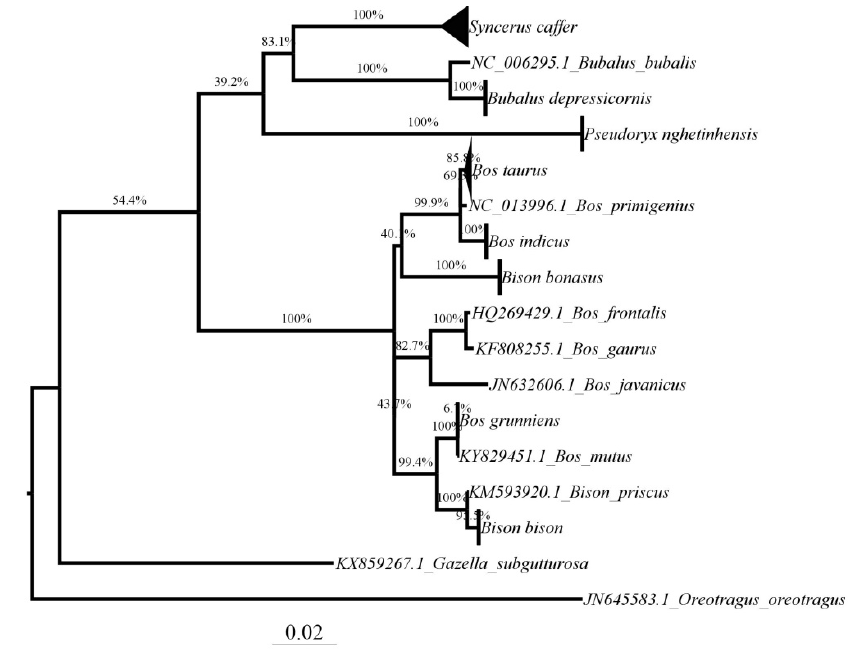
Fig. 4. Maximum Likelihood tree based on the Hasegawa-Kishino-Yano (HKY+G+I) distance using cytochrome c oxidase I ( cox1 ) sequences. The numbers on each branch correspond to the bootstrap support values. The tree was rooted with G. subgutturosa and O. oreotragus ; [{( Sy. Caffer + ( Bu. bubalis + Bu. depressicornis ))+ {(( B. taurus + B. primigenius + B. indicus )+ Bi. bonasus + (( B. frontalis + B. gaurus )+ B. javanicus )+ (( B. grunniens + B. mutus )+ ( Bi. priscus + Bi. bison